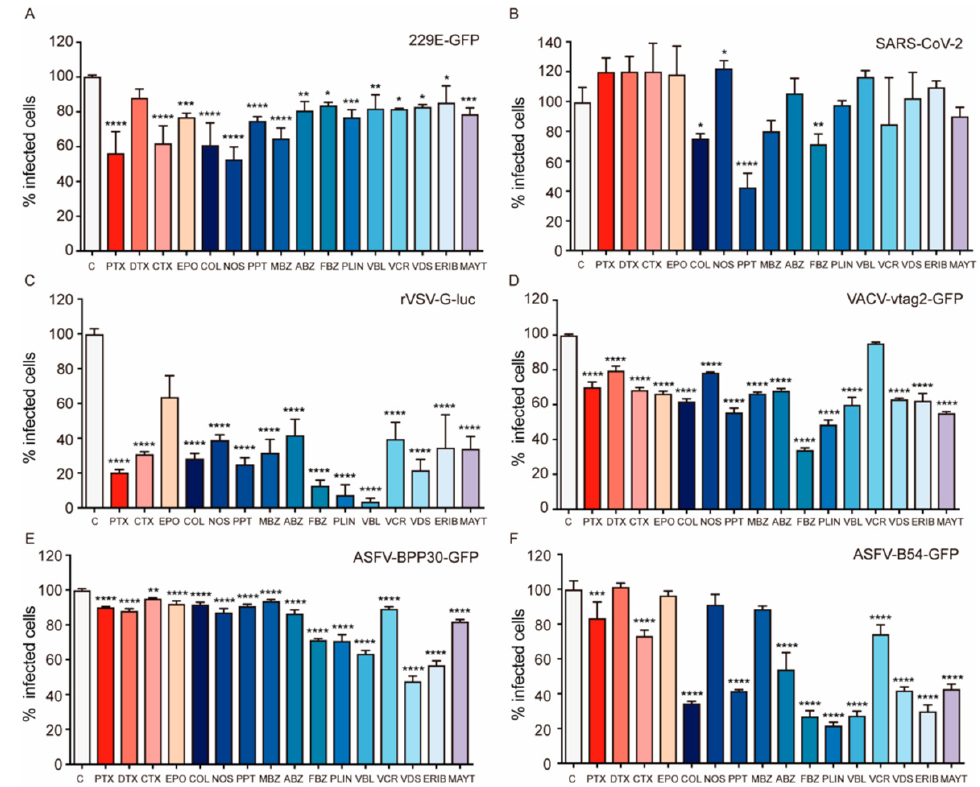
Figure 2. Effect of MTAs in viral infectivity. Cells were pretreated with either compounds or the vehicle DMSO for one hour before infection. The percentages of infection have been normalized to DMSO values. ( A ) Huh-7 cells infected with 229E-GFP detected by flow cytometry after 24 h of infection. ( B ) Antiviral effect on SARS-CoV-2 of compounds at optimal doses, PTX (25 nM), DTX (12.5 nM), CTX (0.5 µ M), EPO (12.5 nM), COL (100 nM), NOS (50 µ M), PPT (100 nM), MBZ (2 µ M), FBZ (2 µ M), ABZ (2 µ M), PLIN (2 nM), VBL (100 µ M), VDS (6 nM), VCR (400 nM), ERIB (2.5 nM), and MAYT (20 nM). ( C ) Infection percentages of VSV-G-luc in Vero-E6 cells detected after 24 h of infection by Relative Light Units (RLU) in a luminometer. ( D ) Infected Vero cells with vtag2GFP detected by flow cytometry after 24 h of infection. ( E ) Infected Vero cells with BPP30GFP detected by flow cytometry after 24 h of infection. ( F ) Infected Vero cells with B54GFP-2 detected by flow cytometry after 24 h of infection. Data presented as mean. Error bars indicate S.D. from three ( A , C – F ) or two ( B ) independent experiments (one-way ANOVA with Bonferroni post-test). Statistically significant differences are indicated by asterisks (**** p < 0.0001, *** p < 0.001, ** p < 0.01, * p < 0.05), n = 9 ( A , C – F ), n = 6 ( B